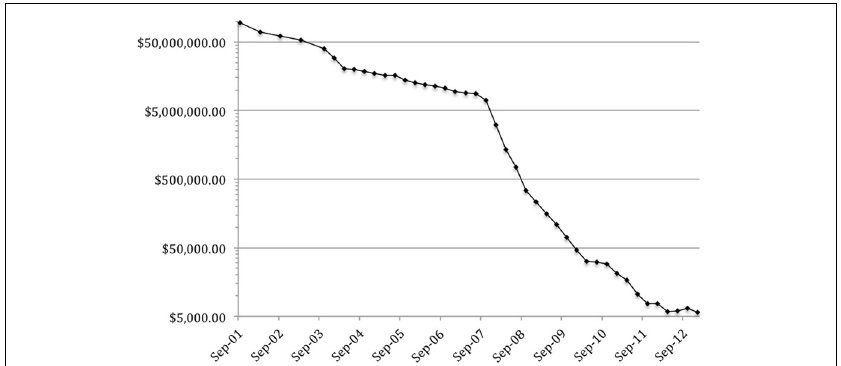
FIGURE 1 | DNA sequencing costs: data from the NHGRI genome sequencing